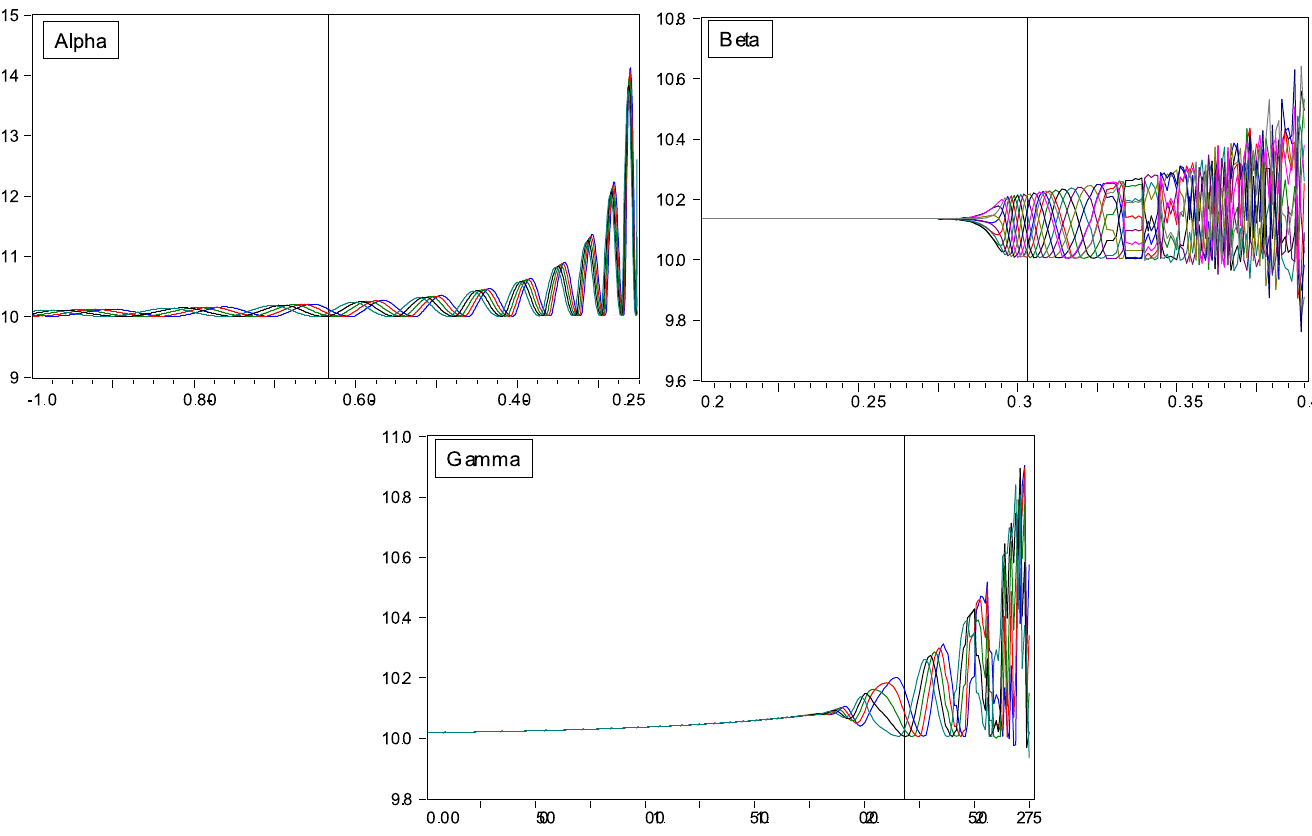
Fig 3. Sensitivity Analysis: Bifurcation Plots. Fig 3 displays bifurcation plots that show how the equilibrium price process changes in response to changes in the three behavioural model coefficients ( α , β , and γ ). In this sensitivity analysis we change one coefficient at a time, while keeping all other coefficients constant at their estimated values. Panel A displays the bifurcation plot for the fundamentalist coefficient α , Panel B the plot for the chartist coefficient β , and Panel C the plot for the switching parameter γ . The vertical lines represent the coefficient values estimated in the